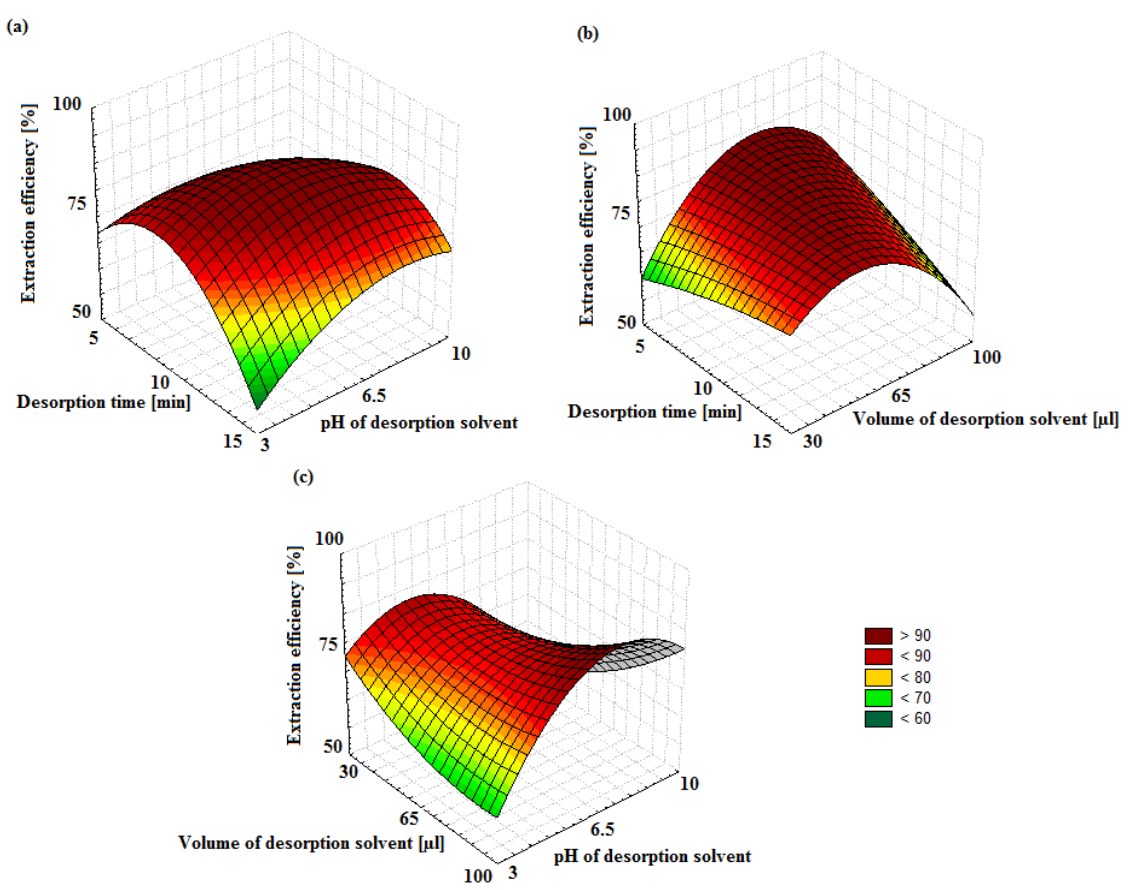
Figure 8. Response surface methodology for the extraction recovery of AMOX in case of optimized parameters such as the desorption time (X 1 ), the pH of the desorption solvent (X 2 ) and the volume of the desorption solvent (X 3 ). (a) X1 vs. X2, (b) X1 vs. X3, (c) X3 vs. X2.